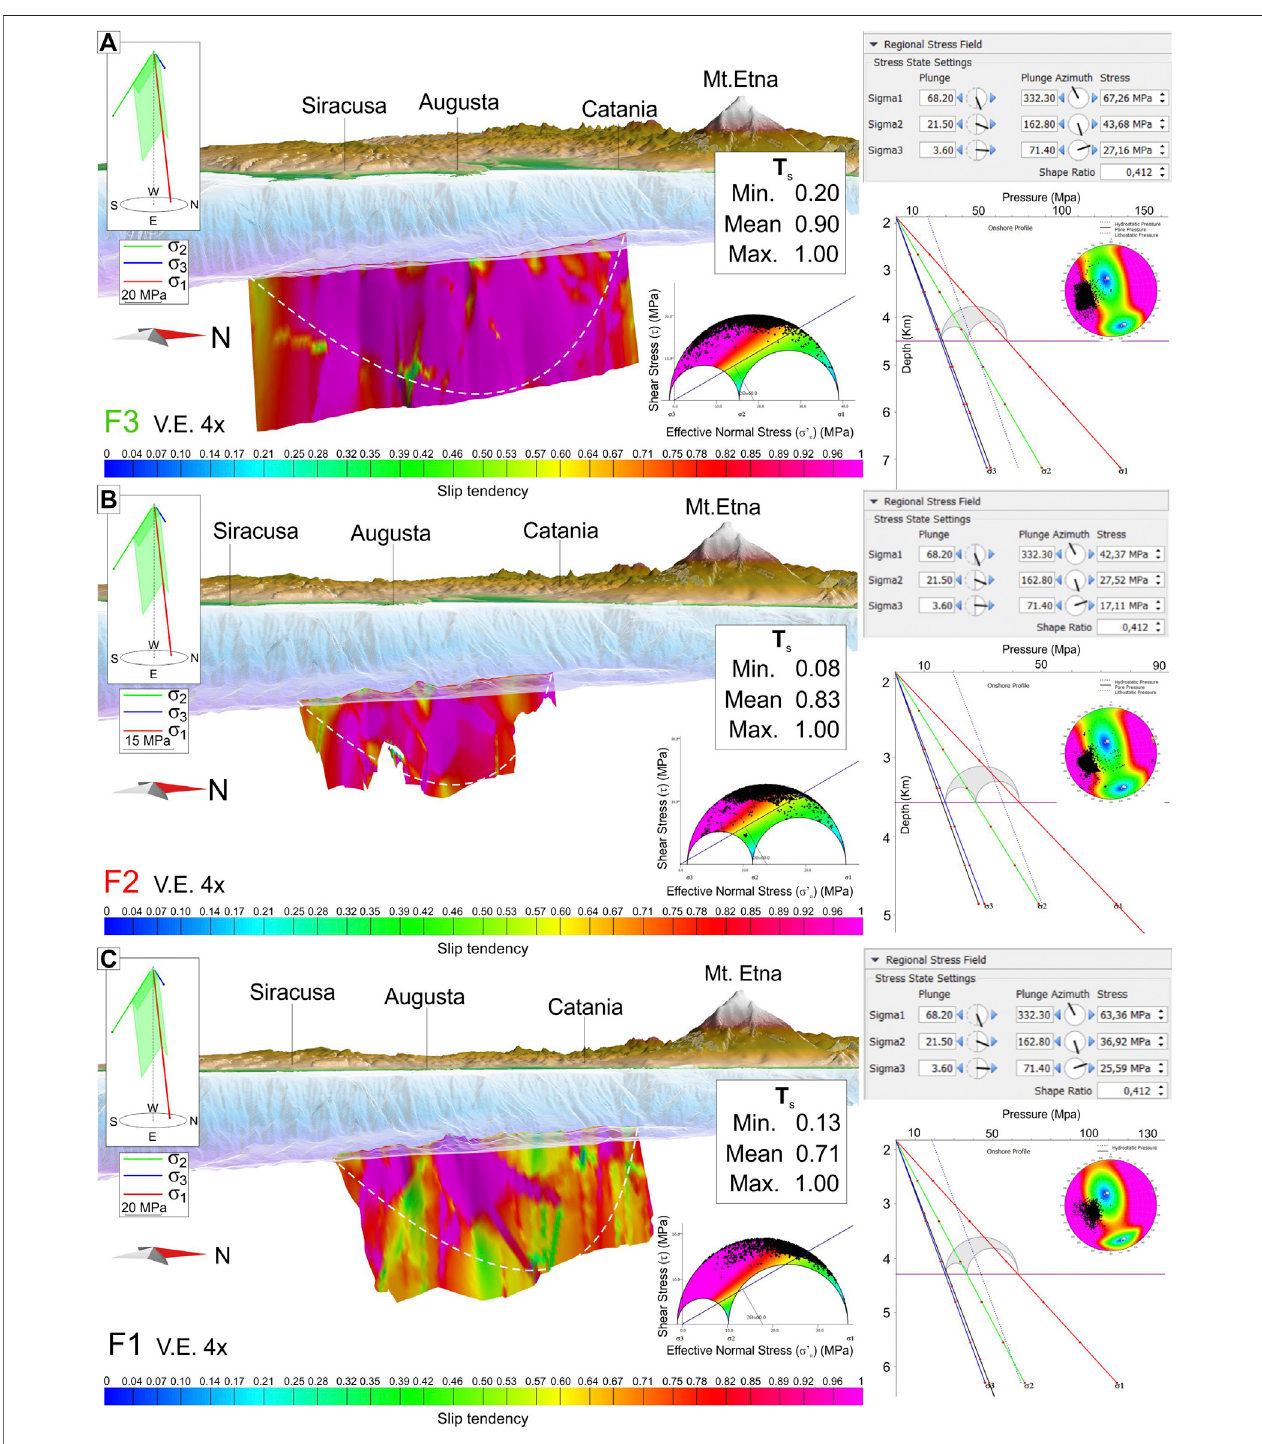
FIGURE 8 | Slip tendency analysis performed on the 2½D modeled fault surfaces (A – C) and based on the remotely applied stress fi eld orientation. Stress parametersandrelatedpressurepro fi lesareshowedintherightpanels.Coloroverlaidonthefaultsurfacesindicatesthepropensity(blue (cid:2) lowandred (cid:2) high)offaultsto be reactivated according to the considered stress fi eld. Dashed line indicates the possible fault planes boundaries.